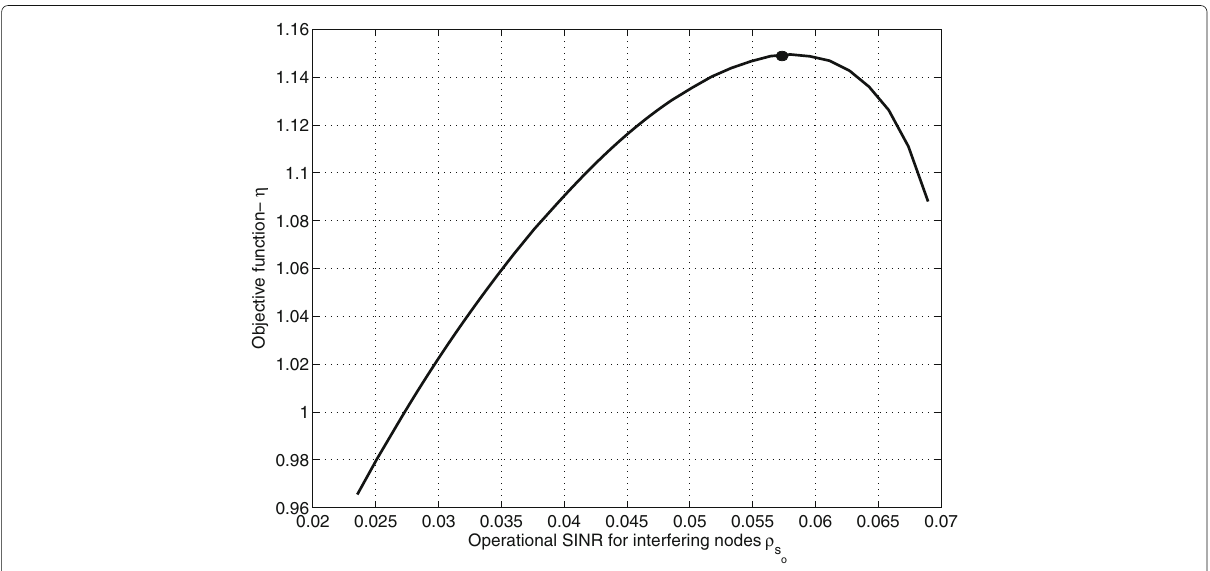
Fig. 9 Throughput of joint compensation. Throughput η for T f = 1000, θ = 0.1, ρ = 2, and N = 15